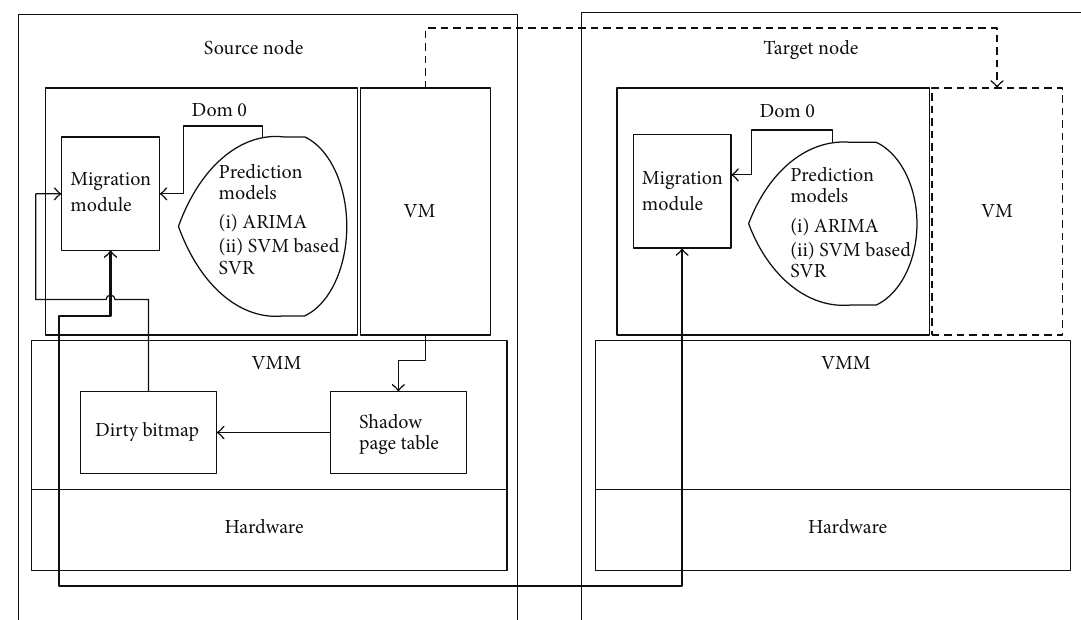
Figure 2: Framework of improved precopy